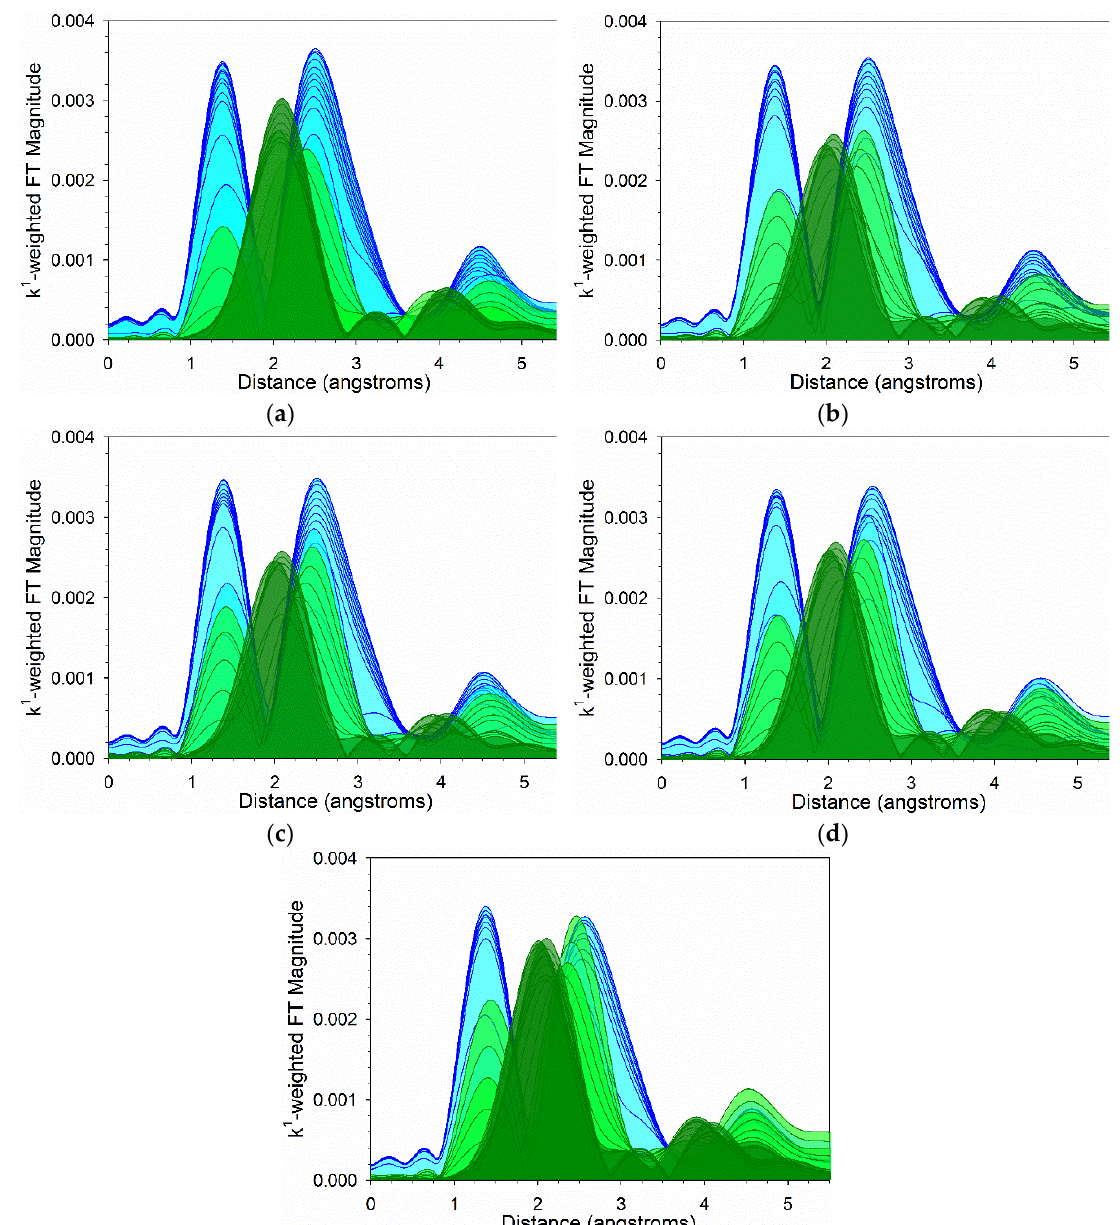
Figure 9. H 2 -TPR-EXAFS spectra (XY view) at the Co K-edge of ( a ) 25%Co/Al 2 O 3 , ( b ) 25%M (M = 5%Ni-95%Co)/Al 2 O 3 , ( c ) 25%M (M = 10%Ni-90%Co)/Al 2 O 3 , ( d ) 25%M (M = 25%Ni-75%Co)/Al 2 O 3 , and ( e ) 25%M (M = 50%Ni-50%Co)/Al 2 O 3 . (Cyan) is reduction of Co 3 O 4 to CoO, and (Green) CoO to Co 0 .